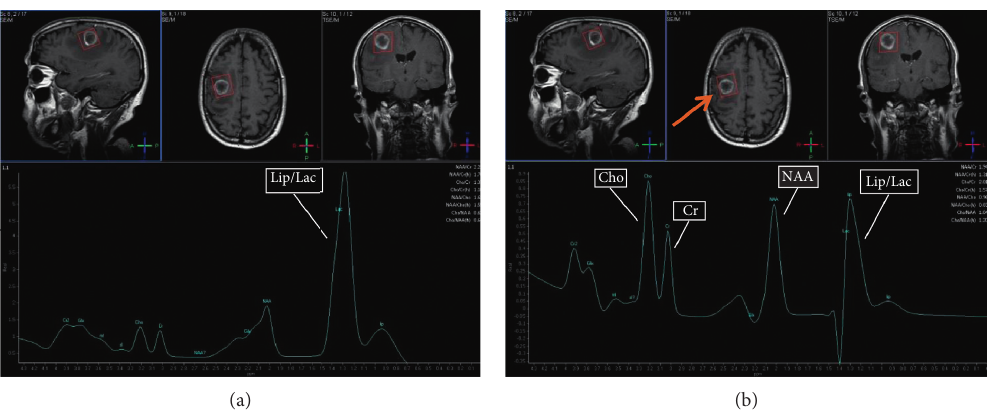
Figure 8: (a) TE 31 msec. (b) TE 144 msec. MRS was performed to differentiate between high-grade glioma and tuberculoma. The lesion was diagnosed as a tuberculoma. At TE31 prominent, lipid peak is seen at 1.3ppm. At TE144, choline is increased. However, Cho :Cr is 1.57 and Cho :NAA is 1.20.